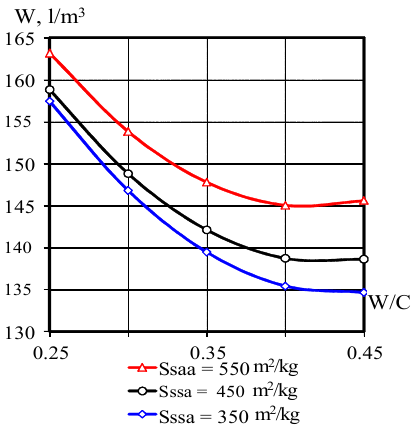
Figure 3. The influence of W/C and PFM 1 additives on the concrete mixture water consumption (S ssa = 450 m 2 /kg, Sl = 13 cm).